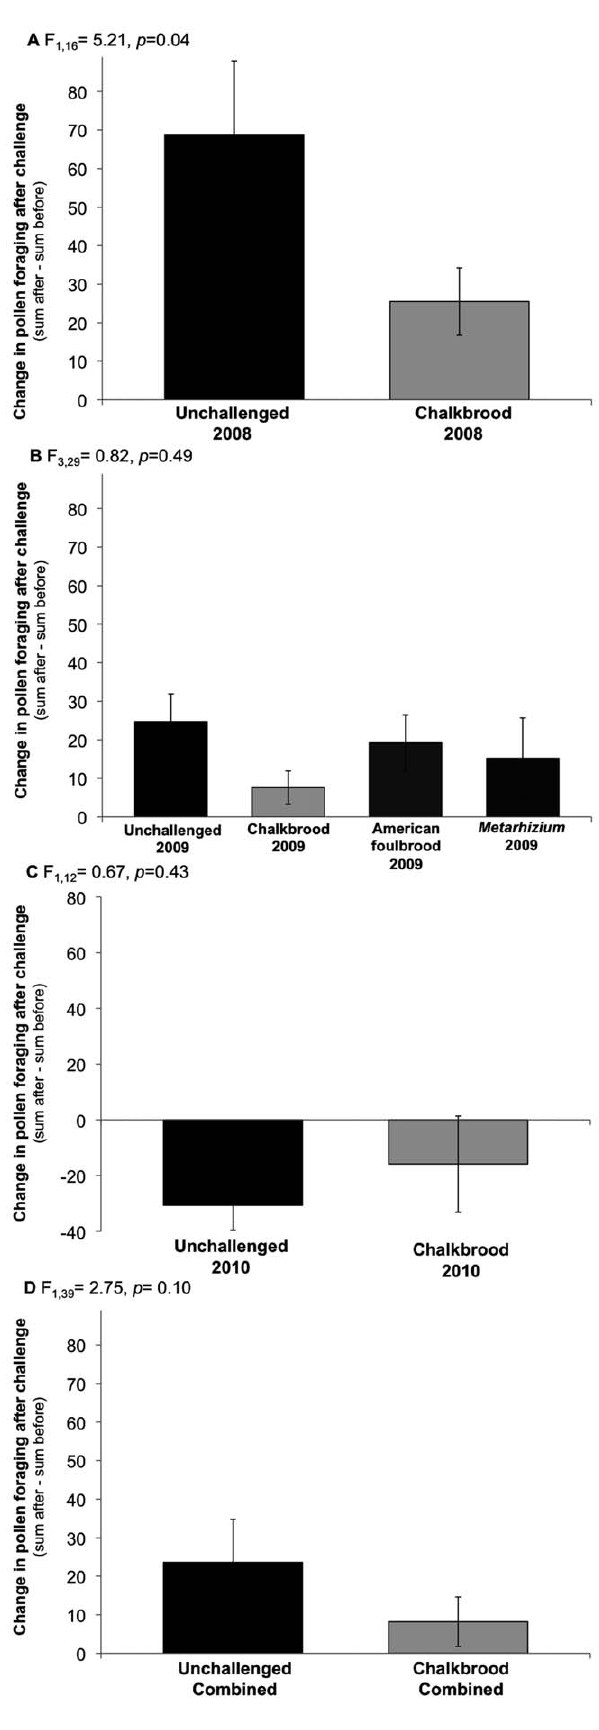
Figure 2. Change in pollen foraging rates before and after challenge. Data were analyzed using ANOVA for each series with p- values reported within each graph. A) 2008 (n=7 unchallenged, n=10 challenged); B) 2009 (n=8 for unchallenged, chalkbrood, and American foulbrood; n=9 for Metarhizium ); C) 2010 (n=6 unchallenged, n=7 challenged); D) Data combined for unchallenged and chalkbrood challenge treatments over the three years of